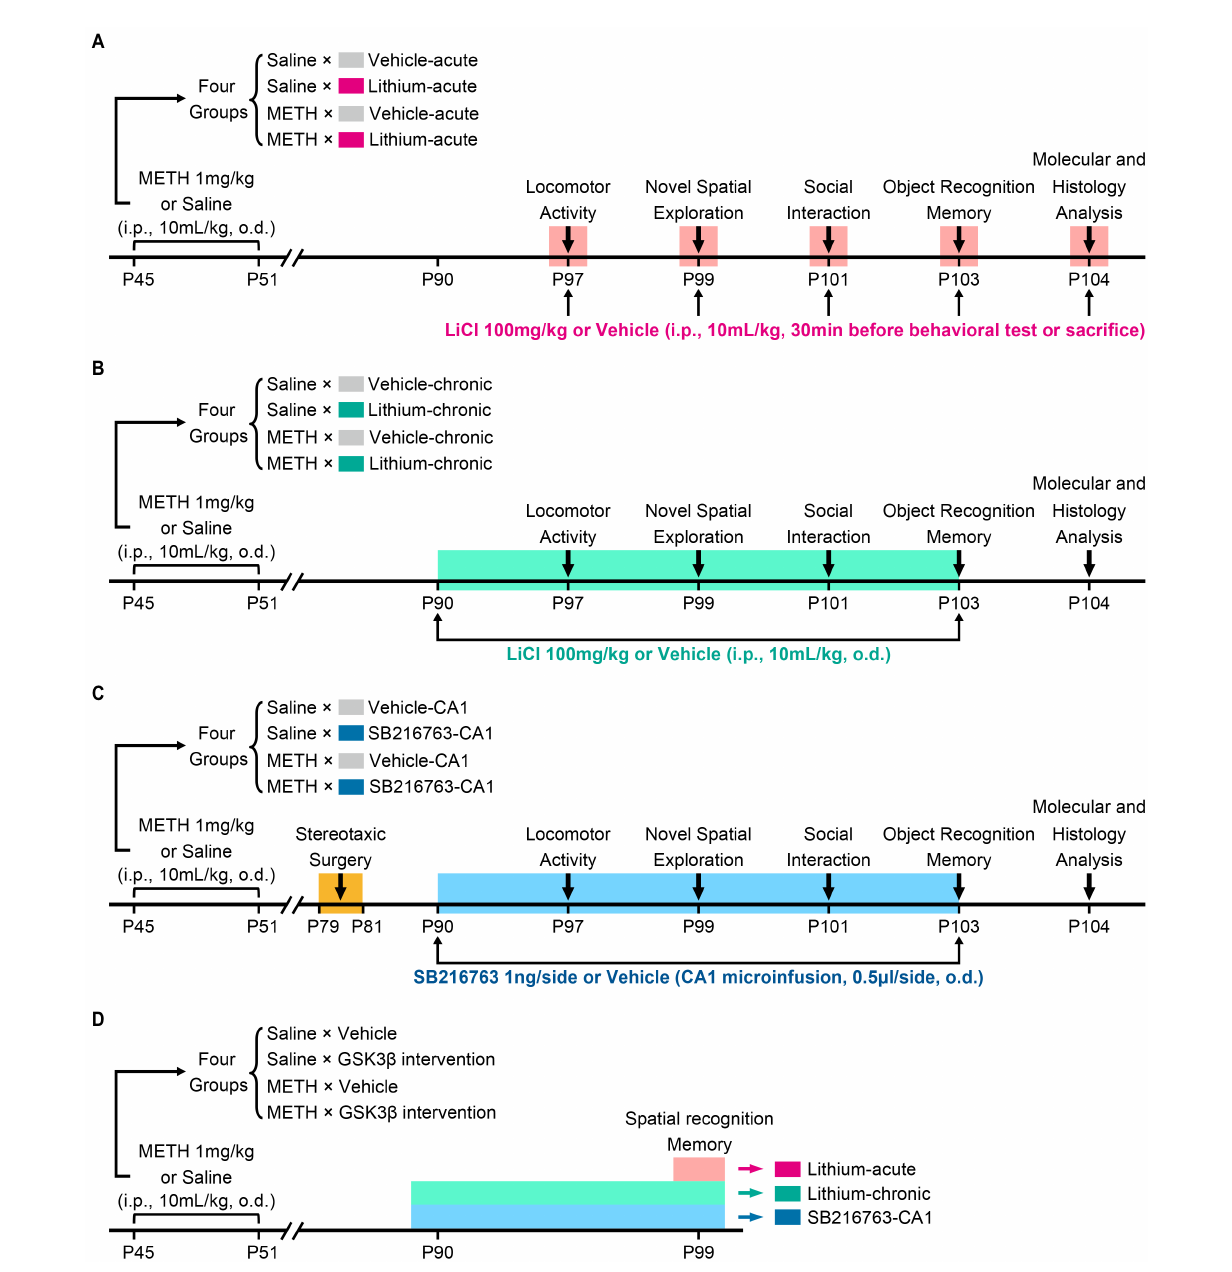
FIGURE 1 Schematic diagram of GSK3 β intervention protocols and experimental time courses. Acute systemic intervention (A) , chronic systemic intervention (B) , and chronic intervention within CA1 (C) were performed to detect the therapeutic effects of GSK3 β inhibition on adolescent METH exposure-induced cognitive, behavioral, and hippocampal ultrastructural deficits in adulthood. To further explain the results of novel spatial exploration, spatial recognition memory was detected in a separate cohort of mice (D)